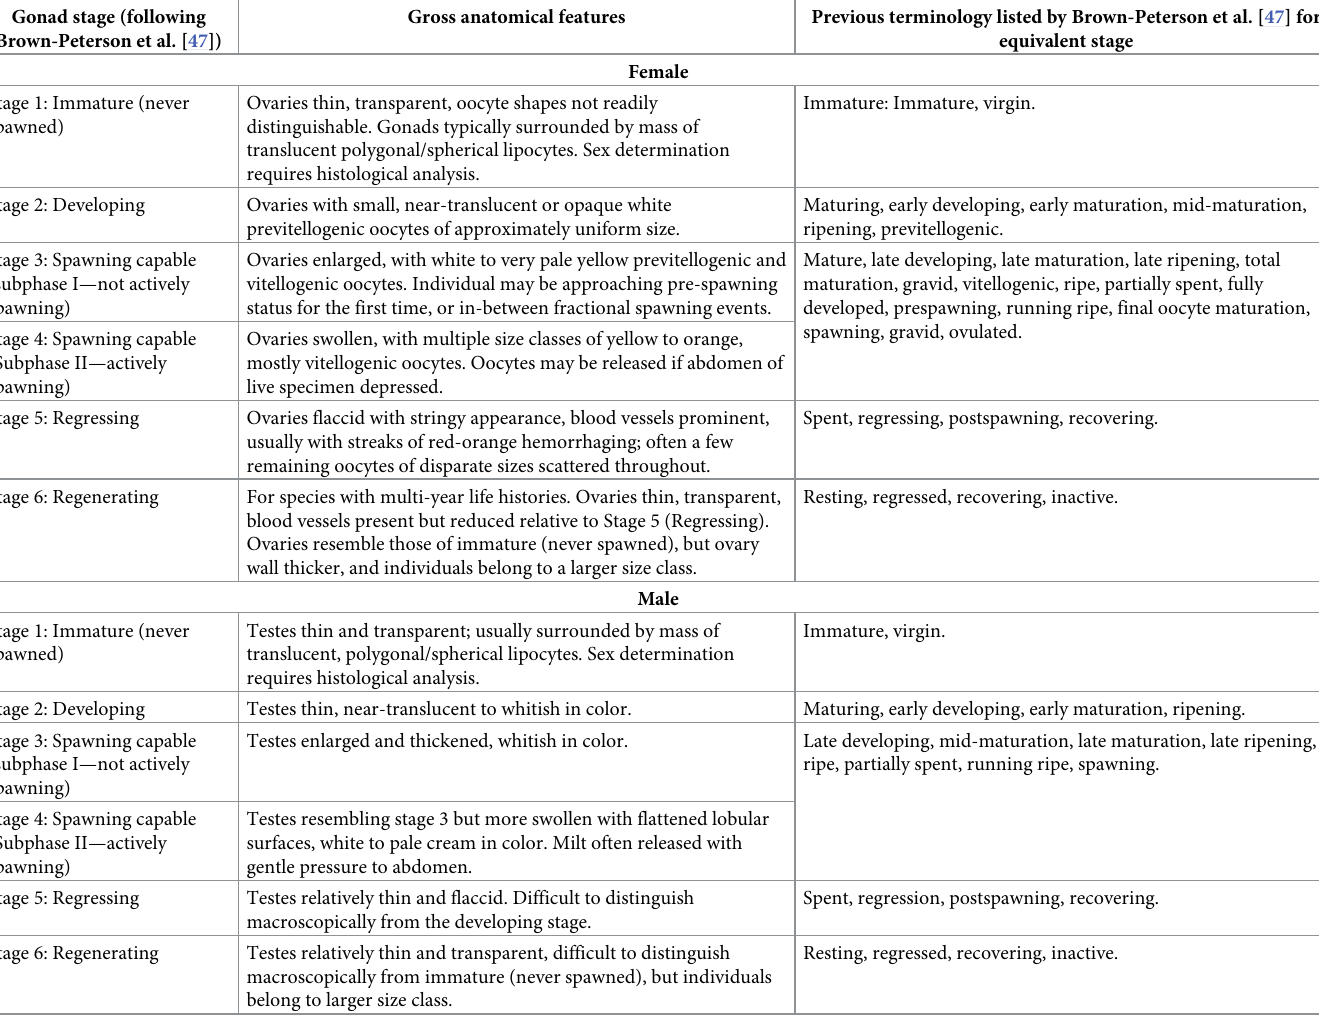
Table 1. Gonadal maturation stages of Brachyhypopomus based on macroscopic analyses of gonadal morphology (see Fig 1). Gonad stage (following Brown-Peterson et al.